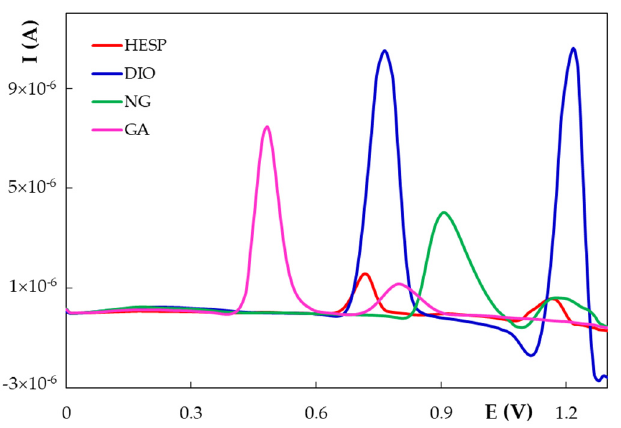
Figure 8. Overlaid differential pulse voltammograms recorded in the anodic direction at H type PGE for 5.00 × 10 − 6 mol/L HESP, 1.00 × 10 − 5 mol/L DIO, 5.00 × 10 − 5 mol/L NG, and 5.00 × 10 − 5 mol/L GA.